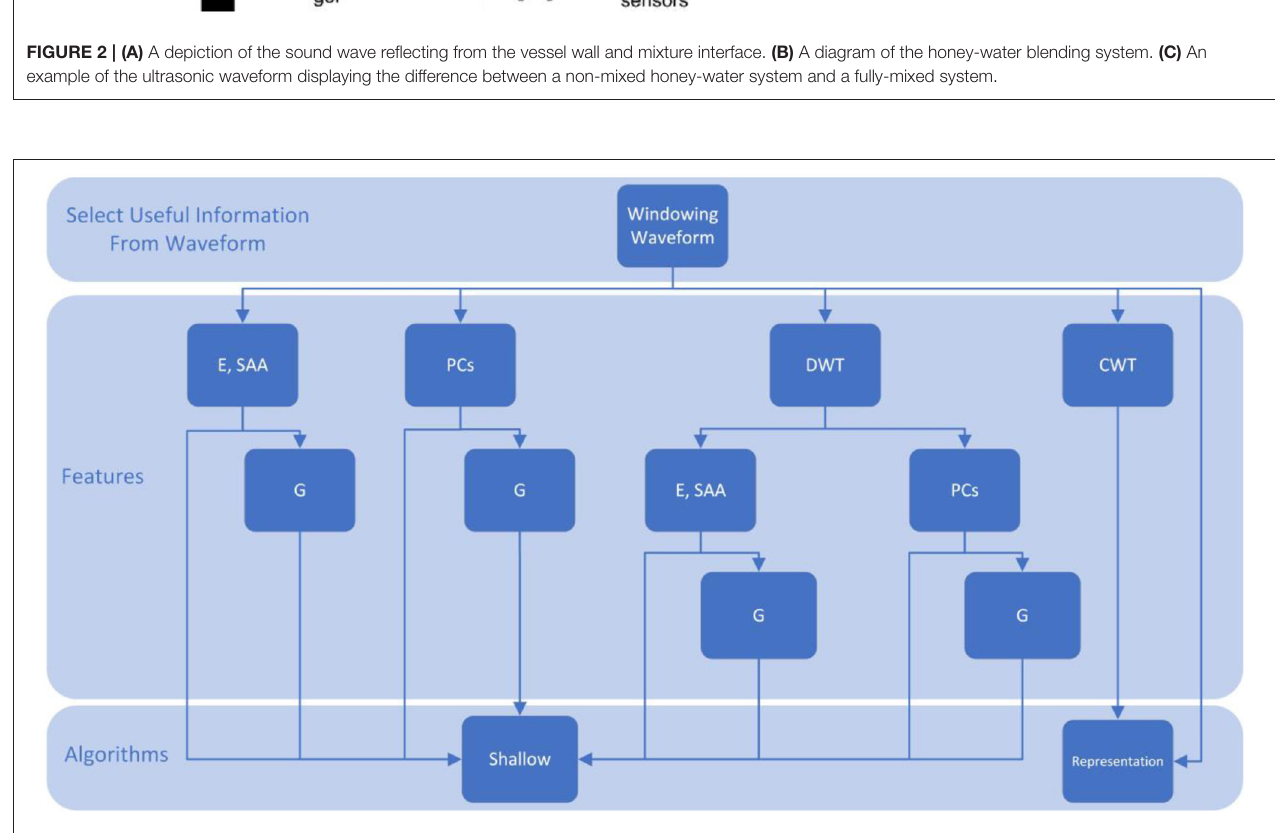
FIGURE 3 | A flow diagram presenting the feature engineering methodology employed. CWT, Continuous Wavelet Analysis; DWT, Discrete Wavelet Analysis; E, Waveform energy; G, Feature gradient; PCs, Principal Components; SAA, Sum Absolute Amplitudes.